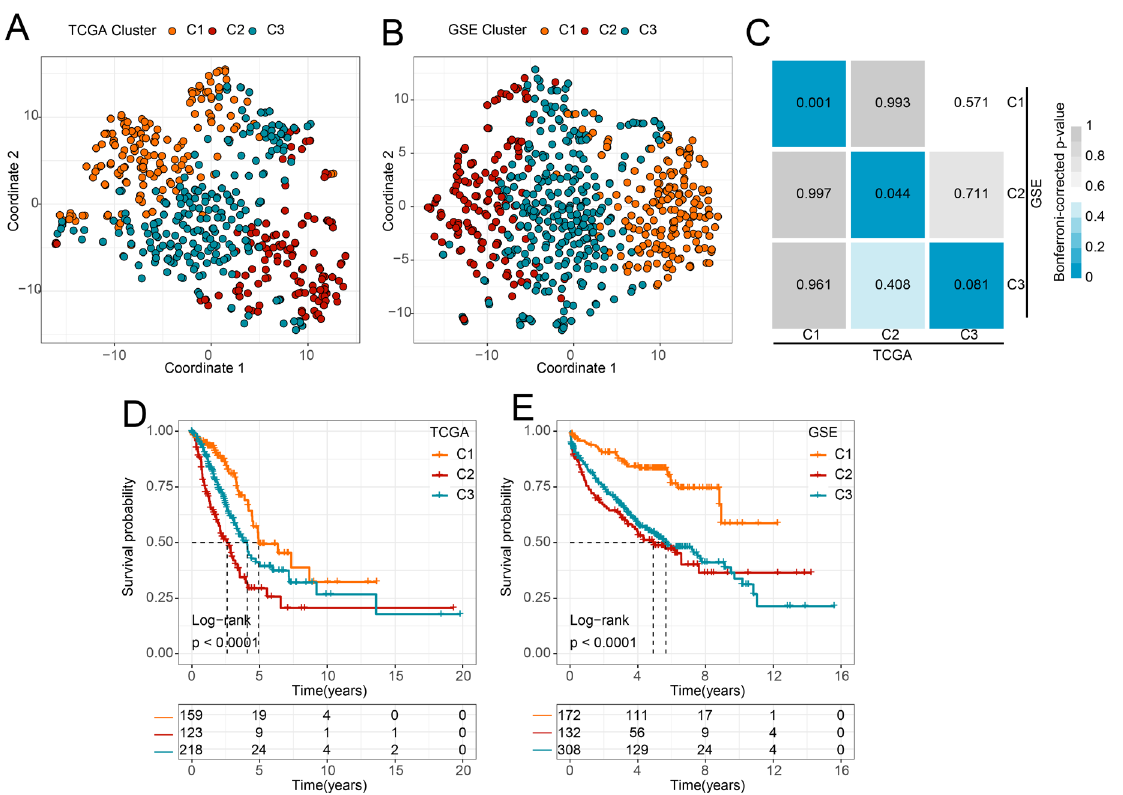
Figure 1 – Molecular classification of LUAD based on metabolism-related genes. T-SNE analysis verified the classification of (A) TCGA and (B) GSEdat into 3 clusters. (C) Submap algorithm showing a close association between TCGA and GSEdat. KM analysis to determine the over survival of the 3 clusters in (D) TCGA and (E)